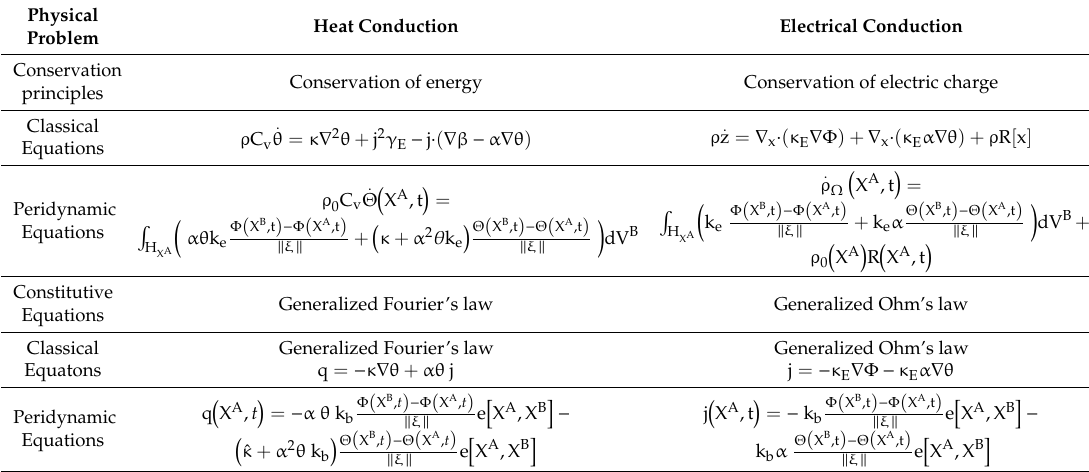
Table 1. Summary of comparison between PD and Classical Equations (Local Vs. PD formulation for